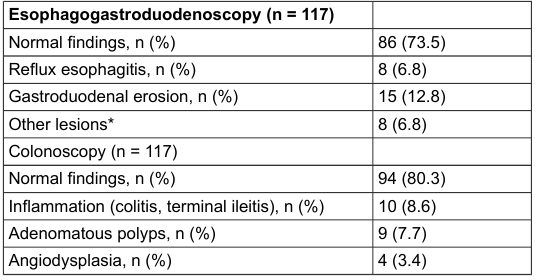
Table 2: Esophagogastroduodenoscopy and colonoscopy endoscopic findings. Esophagogastroduodenoscopy (n = 117)